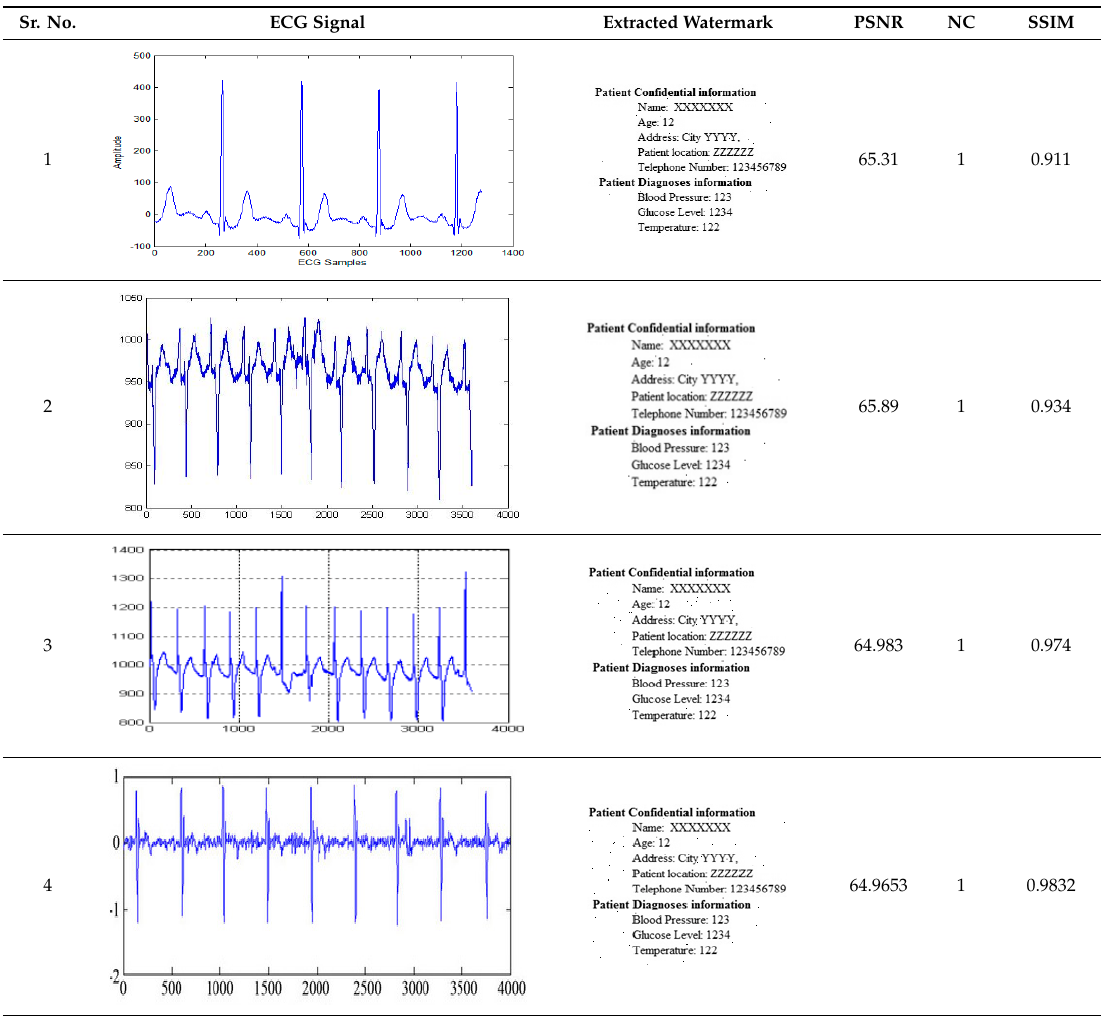
Table 3. Quality of extracted patient’s information.